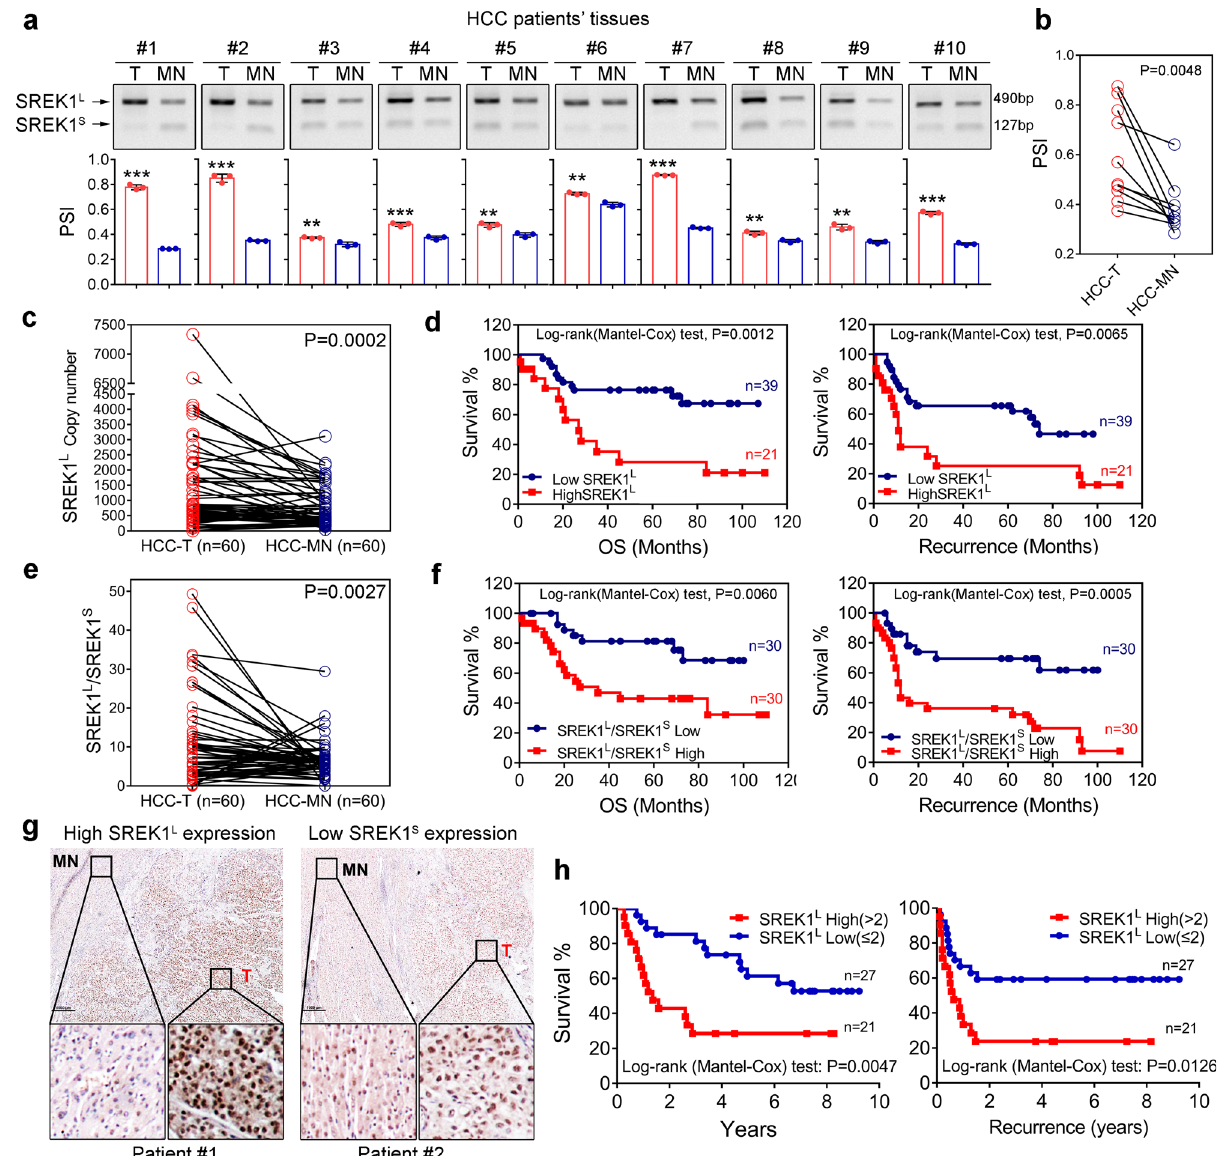
Fig. 1 The variant SREK1 L is enriched in HCC and associated with prognosis. PCR detection with primer set 1 and quanti fi cation of two variants in ten pairs of HCC patient tissues (Supplementary Table 1). Quanti fi ed relative PSI (Percentage-splice-in = splice_in/(splice_in + splice_out)) of the variants a in each tissues of ten pairs ’ samples ( n = 3, data are shown as the mean ± SD, two-tailed, unpaired t test is used) or b the average PSI (Percentage-splice-in = splice_in/(splice_in + splice_out)) in ten pairs tissues are shown (red column indicates tumor (T), Blue column indicates matched normal tissues (MN)), n = 10. c Normalized SREK1 L copy number in 60 pairs of HCC tissues (Supplementary Table 2) and d survival analysis of 60 HCC patients with high and low expression of SREK1 L (using the mean as the cut-off value; OS overall survival). e Normalized SREK1 L /SREK1 S expression ratios in 60 pairs of HCC tissues (Supplementary Table 2), and f survival analysis of 60 HCC patients with high or low SREK1 L /SREK1 S expression (using the median as the cut-off value). g Representative immunohistochemical (IHC) staining fi gures of high or low SREK1 L expression in HCC tissues with SREK1 L detection antibody, scale bar = 1000 μ m. h Survival analysis on high or low SREK1 L expression by IHC in 48 HCC patients was determined and scored independently by